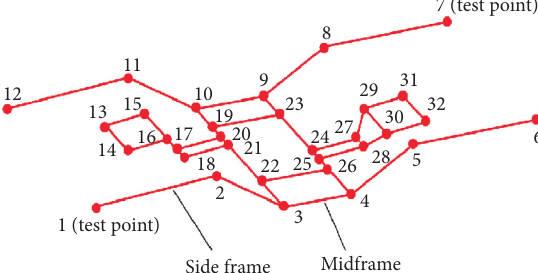
Figure 4: Layout of test points.